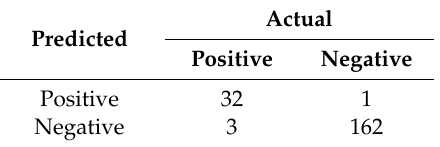
Table 7. Confusion matrix for model Mcar in an experiment.